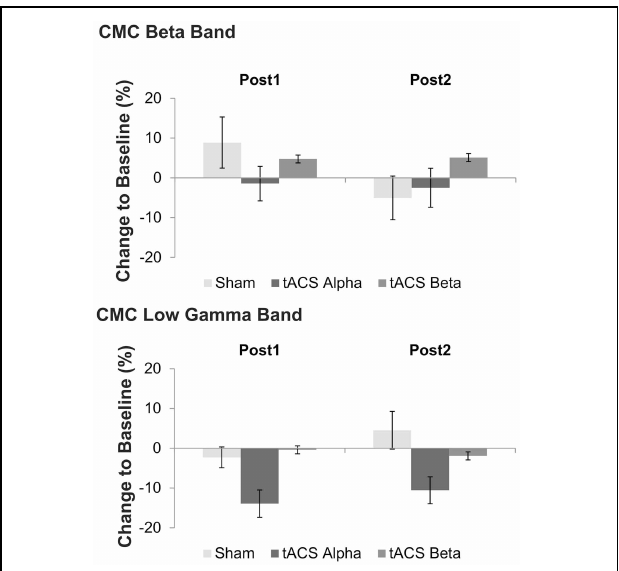
FIGURE 4 | Effects of tACS at 10Hz, 20Hz and sham stimulation on CMC at low gamma frequency at two time points after tACS cessation. Shown are relative changes. Error bars indicate standard error of mean. Please note that a significant main effect of factor stimulation was found on low gamma band CMC, only suggesting more pronounced effects of 10Hz tACS on low gamma CMC as compared to sham and 20Hz stimulation.